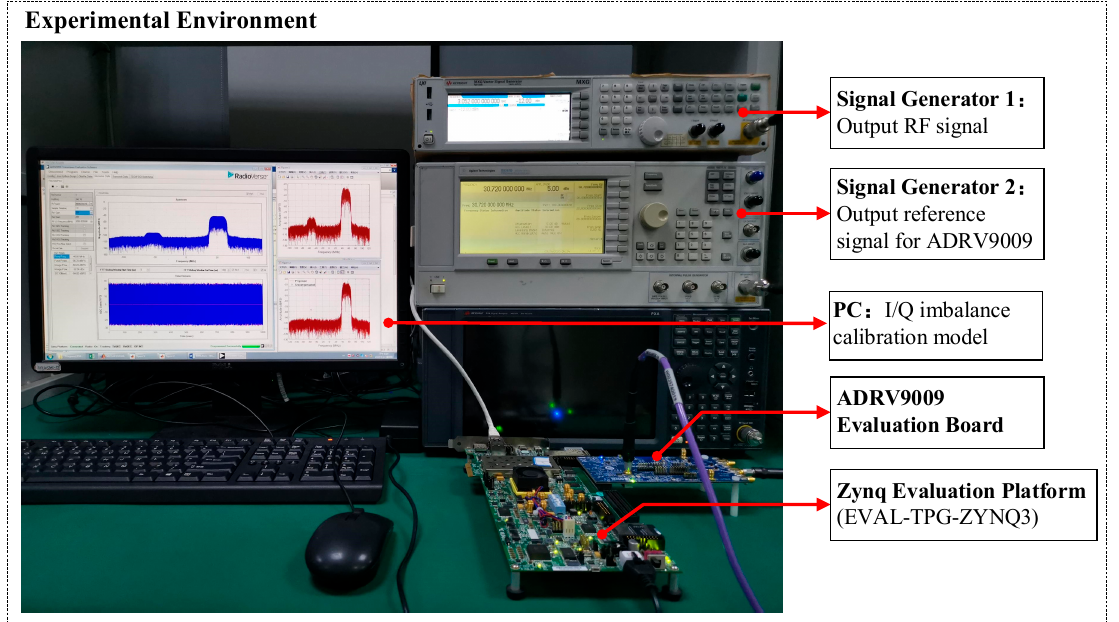
Figure 11. Experimental environment diagram.